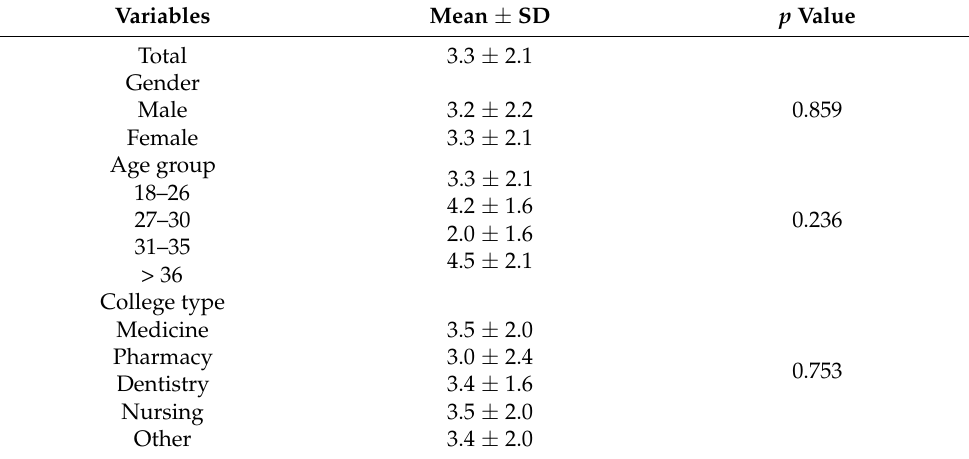
Table 8. Students’ knowledge score towards self-medication ( n =